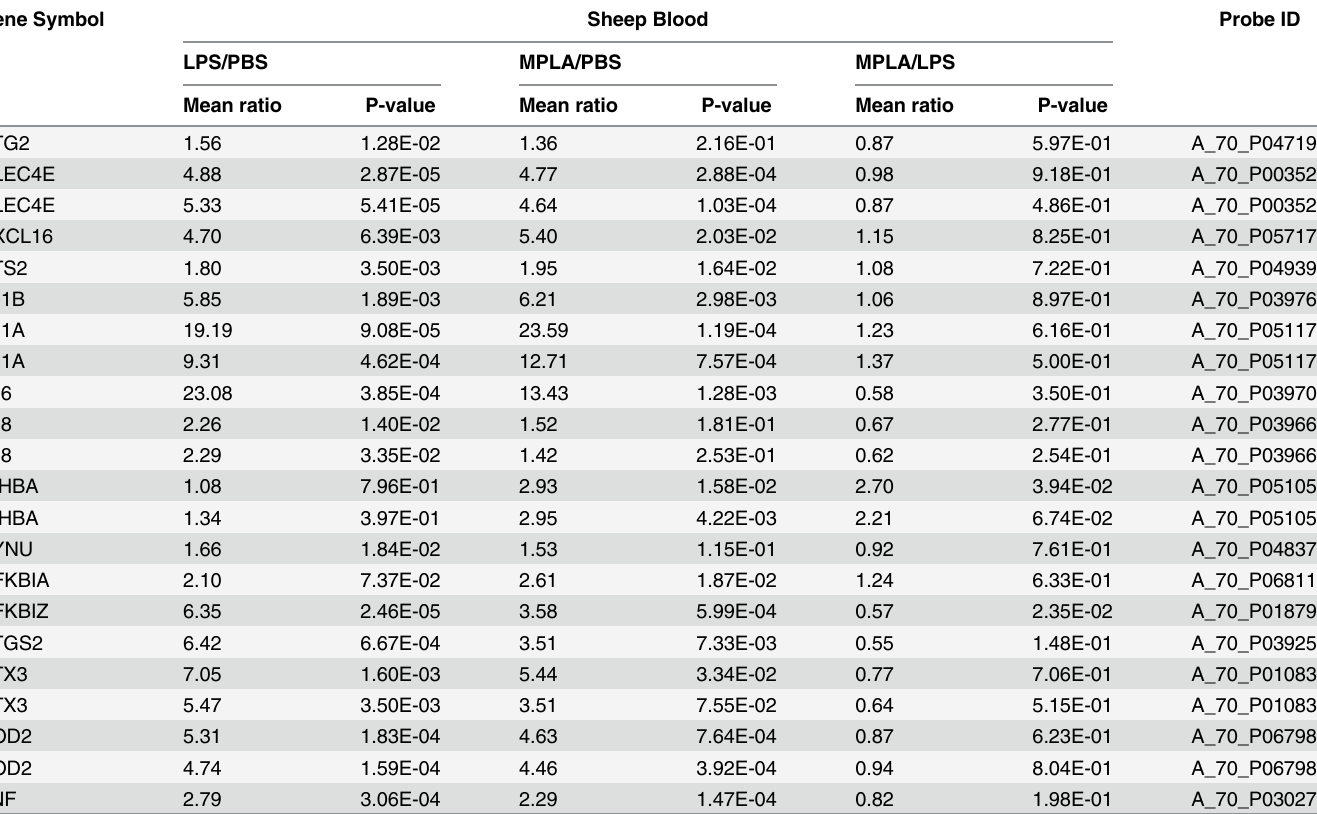
Table 1. Orthologues that changed greater than 1.5-fold in